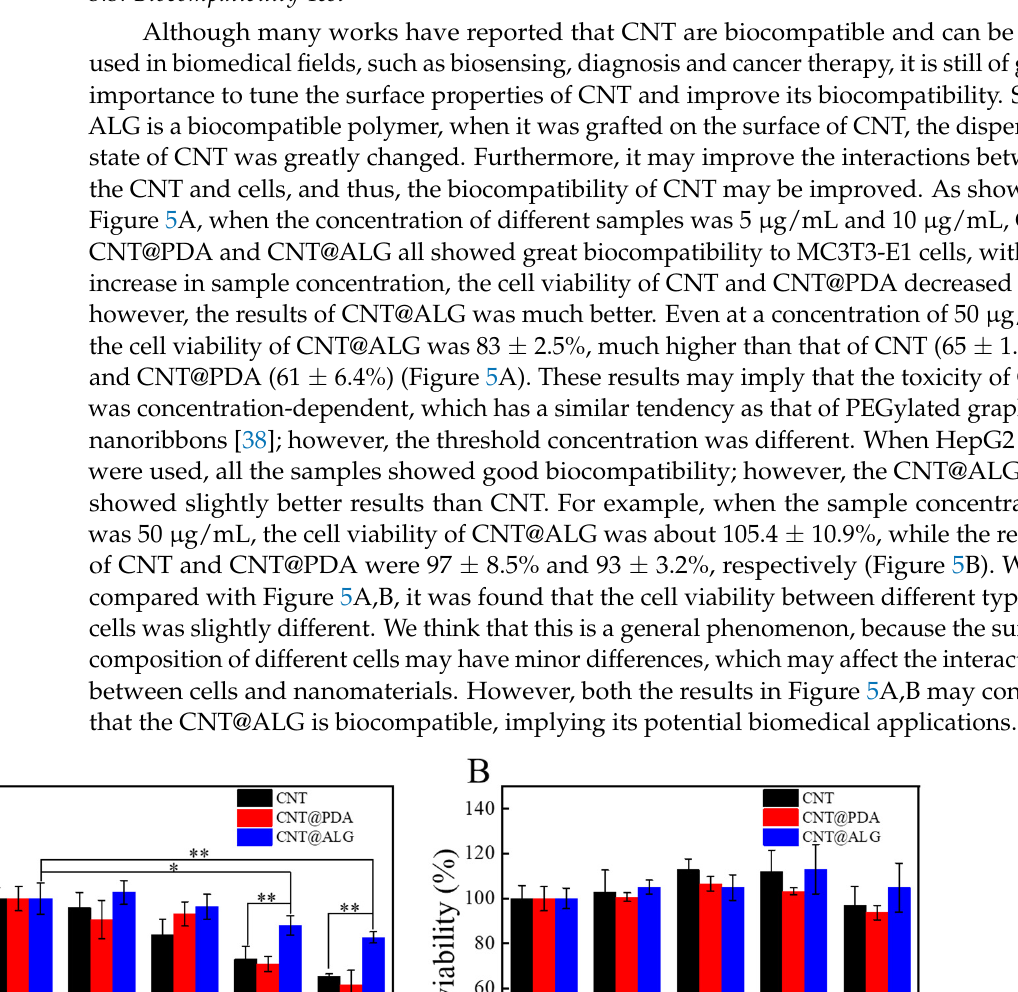
Figure 6. AO/EB staining assay of MC3T3-E1 cells cultured with various samples CNT ( A ), CNT@PDA ( B ), CNT@ALG ( C ) in different concentration. (100× magnification, Bar = 100 μ m). 4. Conclusions In this work, alginate was grafted onto the surface of CNT via the combination of the mussel-inspired method and “thiol-Michael” click chemistry. The results showed that the alginate-modified CNT (CNT@ALG) can disperse well in water for a long time, which may be very helpful for the application of carbon nanotubes as nanofillers in nanocompo- sites. Moreover, the CNT@ALG showed better biocompatibility than native CNT, demon- strating that grafting biocompatible polymers on the surface of CNT is a method to de- crease its toxicity, which provides more possibilities for the application of CNT in the bi- ological field. Author Contributions: H.Y.: Investigation, Methodology, Writing original draft. M.Z.: Investiga- tion, Date curation. P.W.: Methodology. Y.L.: Date curation. J.W.: Conceptualization, Project admin- istration, Write-review & editing. All authors have read and agreed to the published version of the manuscript. Funding: This research was funded by Jiangxi Key Research and Development Program (NO.20202BBG73012), and National Natural Science Foundation of China (Nos. 52163016).